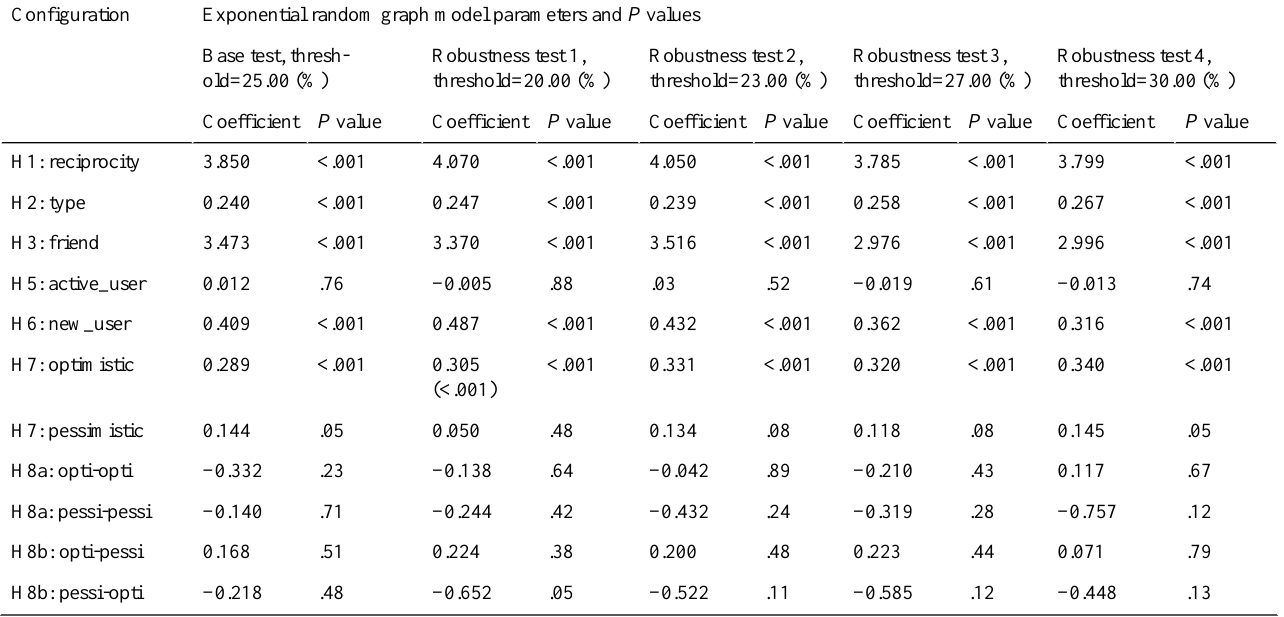
Table 3. Results of robustness tests, new users evaluated under different thresholds. Exponential random graph model parameters and P valuesConfiguration